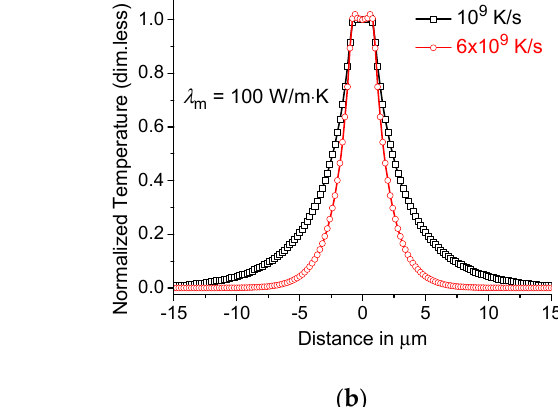
Figure 4. Normalized scanning rate ∂ T / ∂ t vs. temperature in the center of the membrane for the power P ( t ) shown in the inset ( a ) and the temperature profile T ( t 0 , r ) ( b ) for R = 10 9 K/s and 6 · 10 9 K/s—black squares and red circles, respectively. The heater acts uniformly in the ring r ∈ ( r 1 , r 0 ) at r 1 = 2 r 0 /3. Thermal conductivity of the membrane λ m = 100 W/m · K.